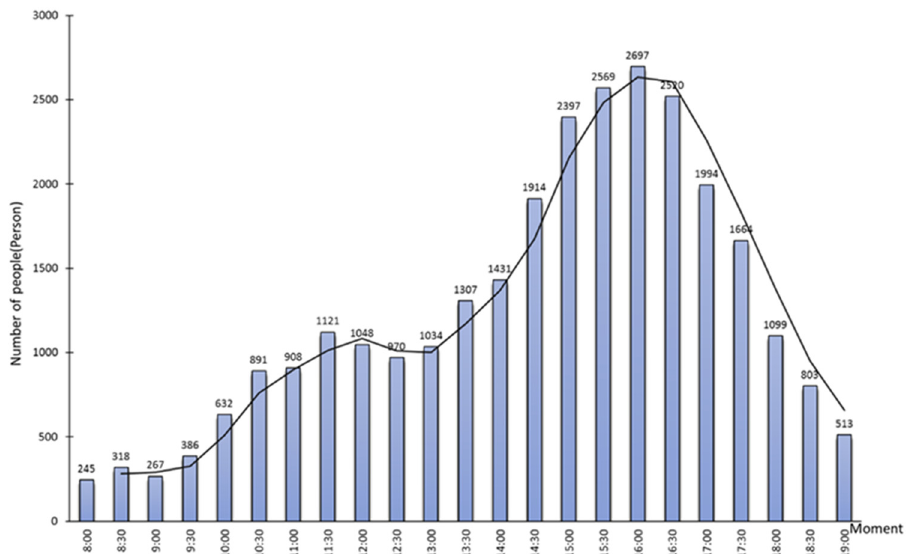
Figure 7. Changes in the number of people inside Binjiang Green Space, Xuhui District, Shanghai, China on 5 May 2021.